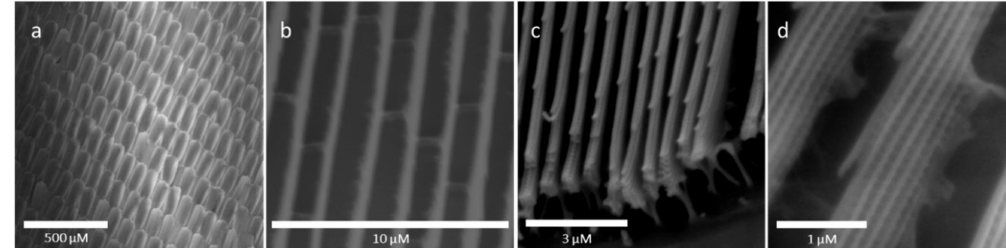
Figure 1. SEM images of the Morpho didius butterfly: ( a ) dorsal forewing scales; ( b ) ridges along the wing scales; ( c ) ridges with branch-like lamella visible; ( d ) side view of ridges with lamella and microribs